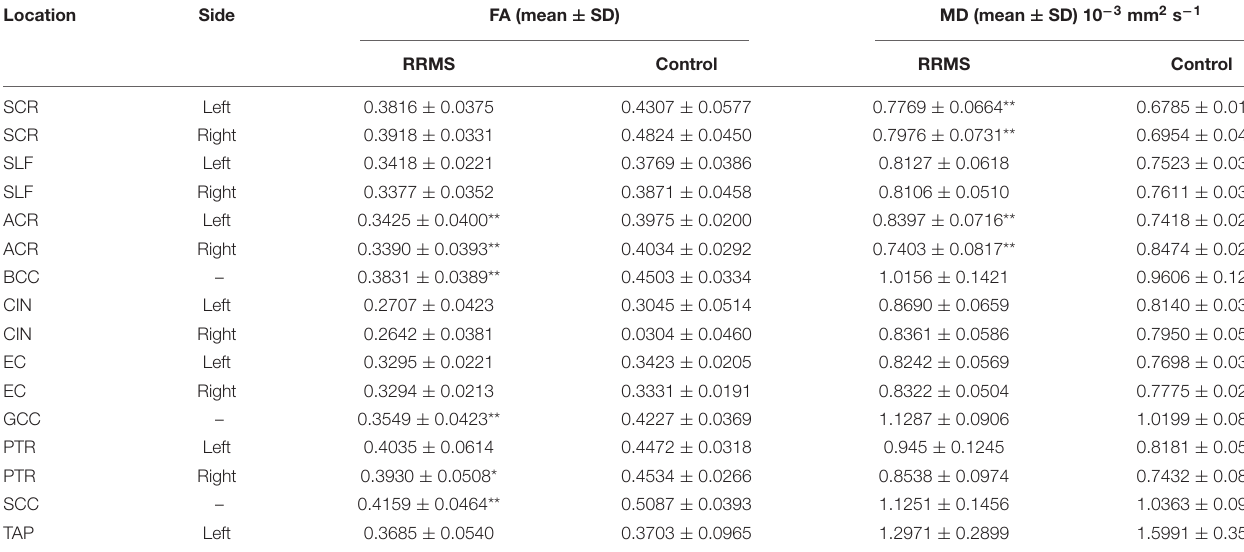
TABLE 1 | Comparison of DTI metrics of FA and MD in NAWM tracts between RRMS patients and controls using two-tailed Student’s t -test. Location